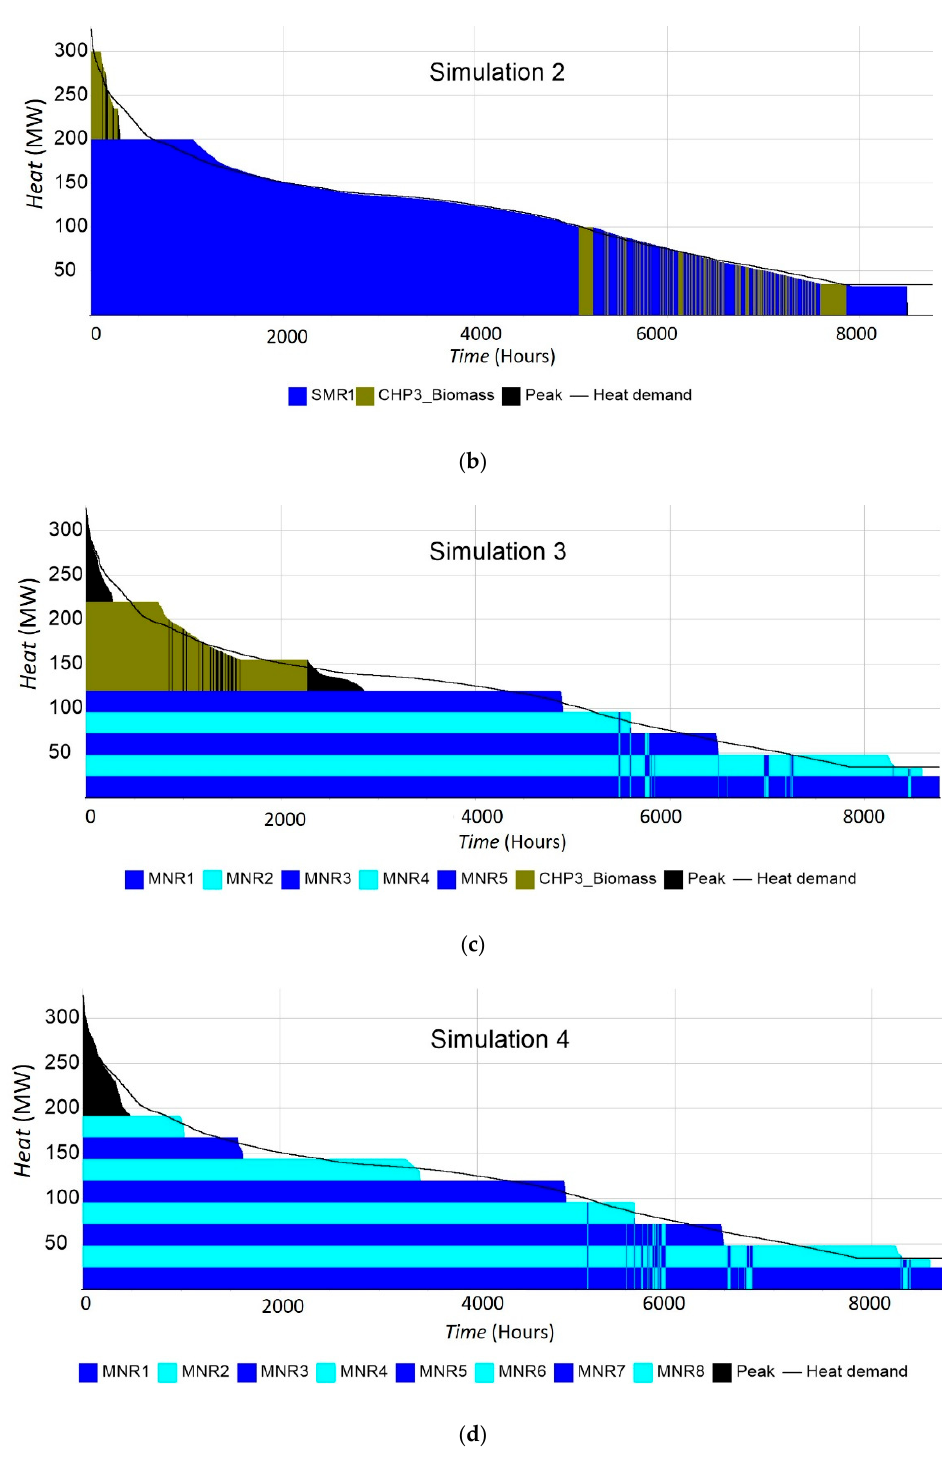
Figure 3. Duration curves: ( a ) Simulation 1; ( b ) Simulation 2; ( c ) Simulation 3; ( d ) Simulation 4.